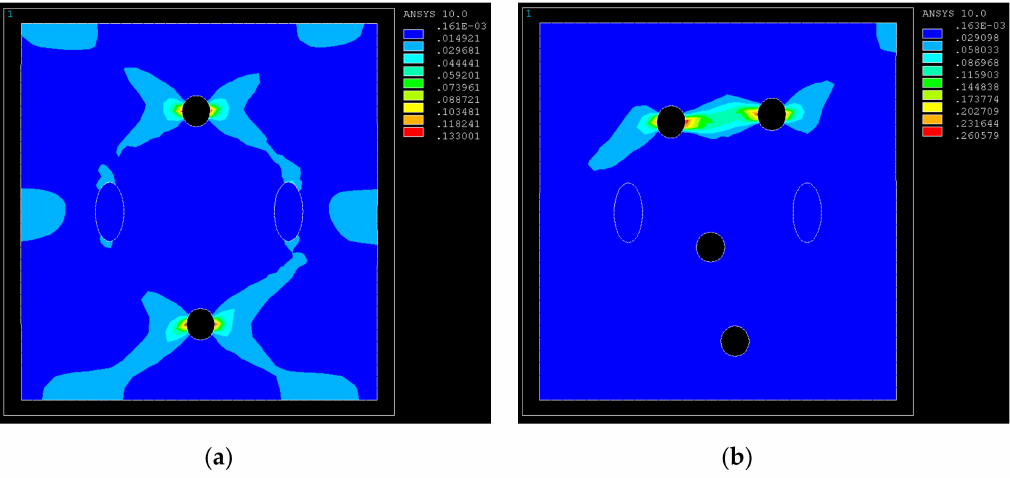
Figure 2. Stress diagram of GRANs with di ff erent porosities, ( a ) 1.2%, ( b ) 2.4%, ( c ) 3.6%, and ( d ) 4.8%.